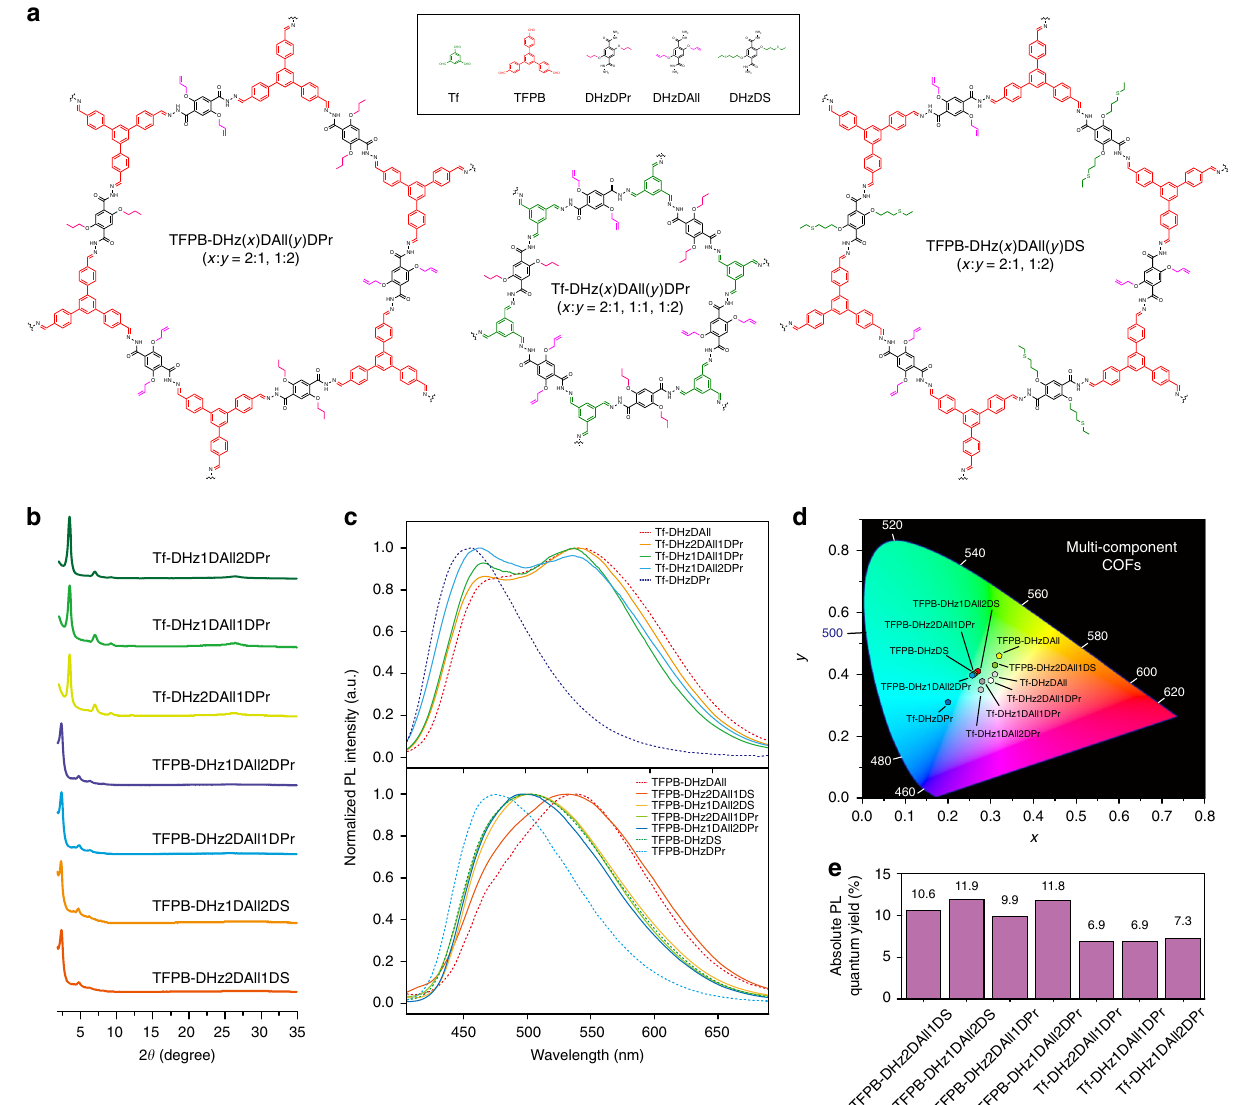
Fig. 5 Fine-tuning of the PL emission via a multicomponent COF strategy. a Synthetic scheme for accessing the multicomponent COFs. b PXRD patterns. c Solid-state PL spectra. d CIE-1991 chromaticity diagram. e Absolute PLQYs of various multicomponent